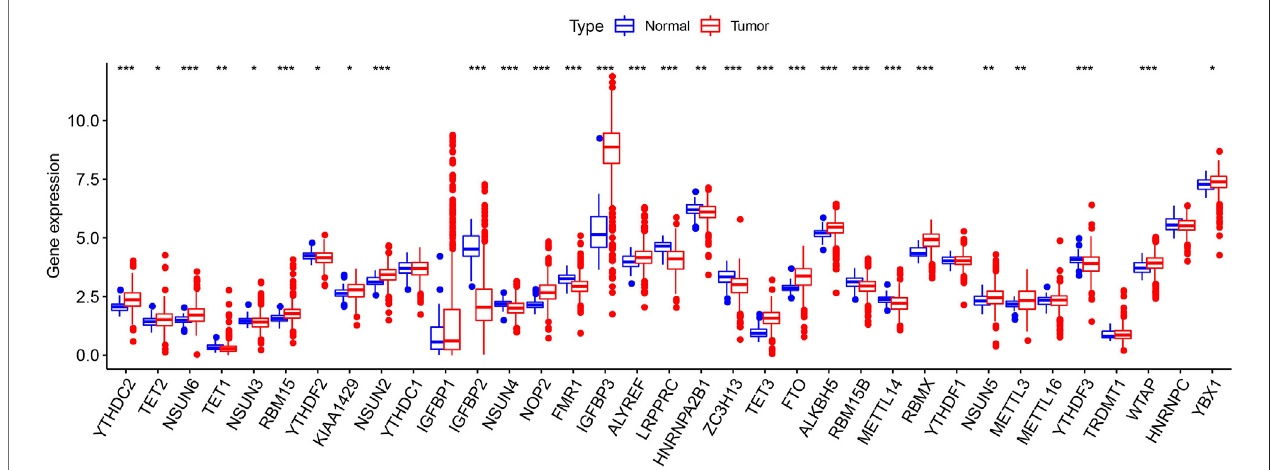
FIGURE 2 | Expression pattern of m6A and m5C regulators in TCGA ccRCC cohort. Difference expression of 35 m6A and m5C methylation regulators. * p < 0.05, ** p < 0.01, and *** p <